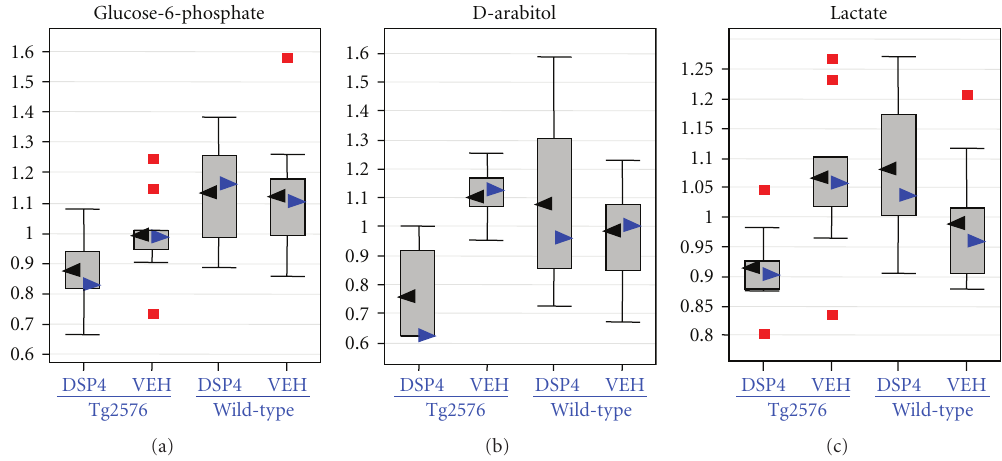
Figure 5: Carbohydrate metabolism. Box plots demonstrating selective depressions in the brains of glucose-6-phosphate (an early intermediary of anaerobic glycolysis as well as the pentose monophosphate shunt), lactate the end product of anaerobic glycolysis, and D-arabitol, a polyol with antioxidant properties which is thought to be a product of the pentose phosphate pathway. For each metabolite, the distribution of values within each of the four cohorts is represented as a Whisker plot, with the relative normalized intensity as the abscissa. Mean values represented by the black arrowheads, median values by blue arrowheads. Detailed statistical comparisons of each of the pictured metabolites in the four cohorts are given in Table 1.